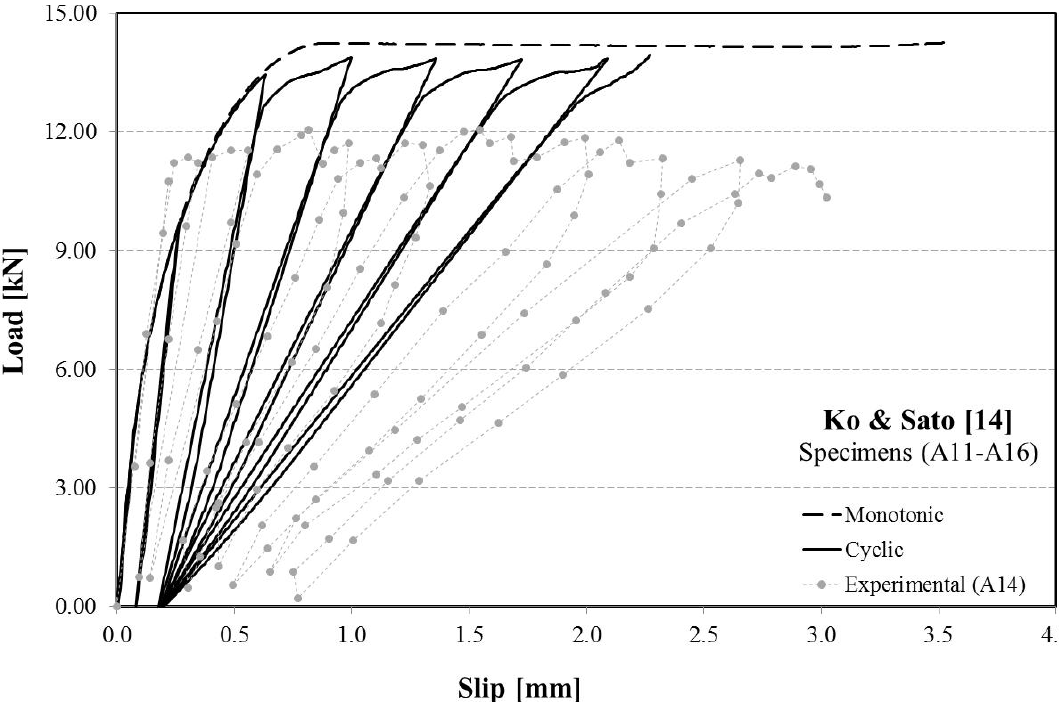
Figure 6. Load-slip response under monotonic and cyclic actions of FRP strips glued on concrete [14]—Linear